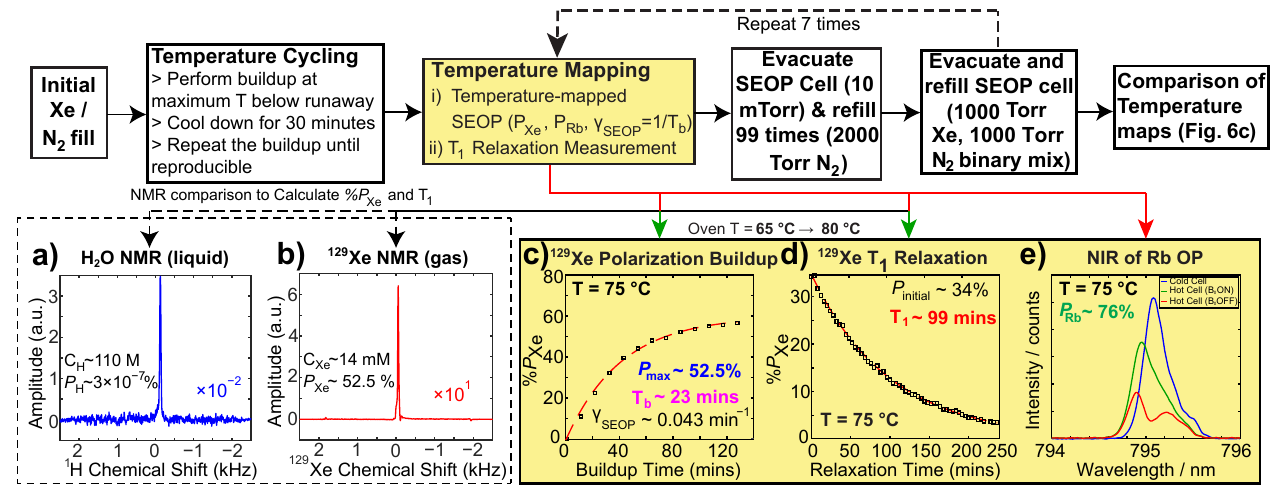
Figure 4. Synopsis of SEOP cell reloading quality assurance (QA) study consisting of 700 total SEOP cell gas mixture refills. 129 Xe polarization (% P Xe ) is calculated by comparing the peak area integral of HP 129 Xe NMR spectra ( b ) with thermally-polarized 1 H reference spectra ( a ). This process is repeated at fixed intervals to observe 129 Xe polarization build-up ( c ) and decay ( d ) over time, respectively, providing a build-up rate ( γ SEOP ) and a relaxation time constant ( T 1 ) for each corresponding curve. Comparison of NIR pump laser spectra ( e ) facilitates calculation of an estimate of the average Rb polarization (% P Rb ) throughout the cell. Key performance indicator (KPI) variables include steady- state % P Xe , γ SEOP , T 1 , and % P Rb , which can also be plotted as a function of SEOP cell temperature, as described in the